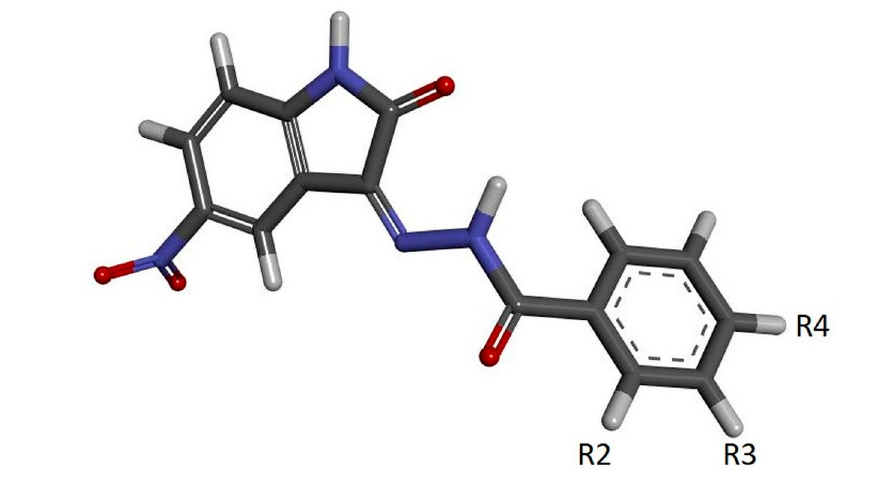
Figure 3. The graphic representation of 5-nitroisatin-based benzoylhydrazines. The markings R2, R3 and R4 represent the places of chemical group substitution. The derivative markings consist of a number symbolizing the place of substitution and the letter assigned for a specific chemical group.